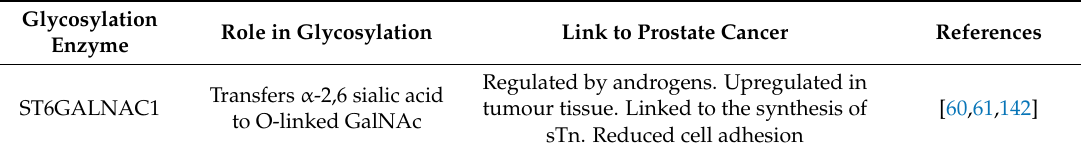
Table 4. Summary of glycosylation enzymes with roles in prostate cancer. HBP: hexosamine biosynthetic